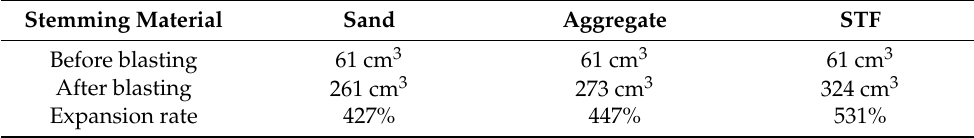
Table 7. Results for blast hole expansion of the AUTODYN lead block